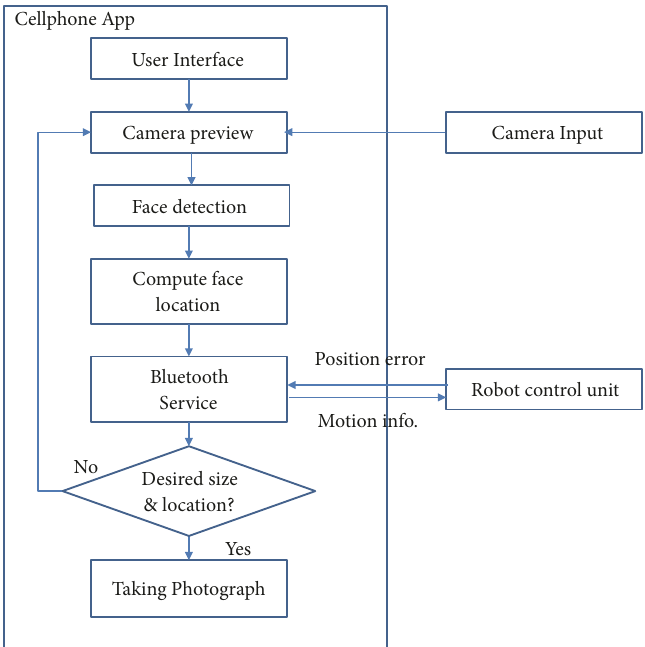
Figure 11: Flowchart of robotic photographing